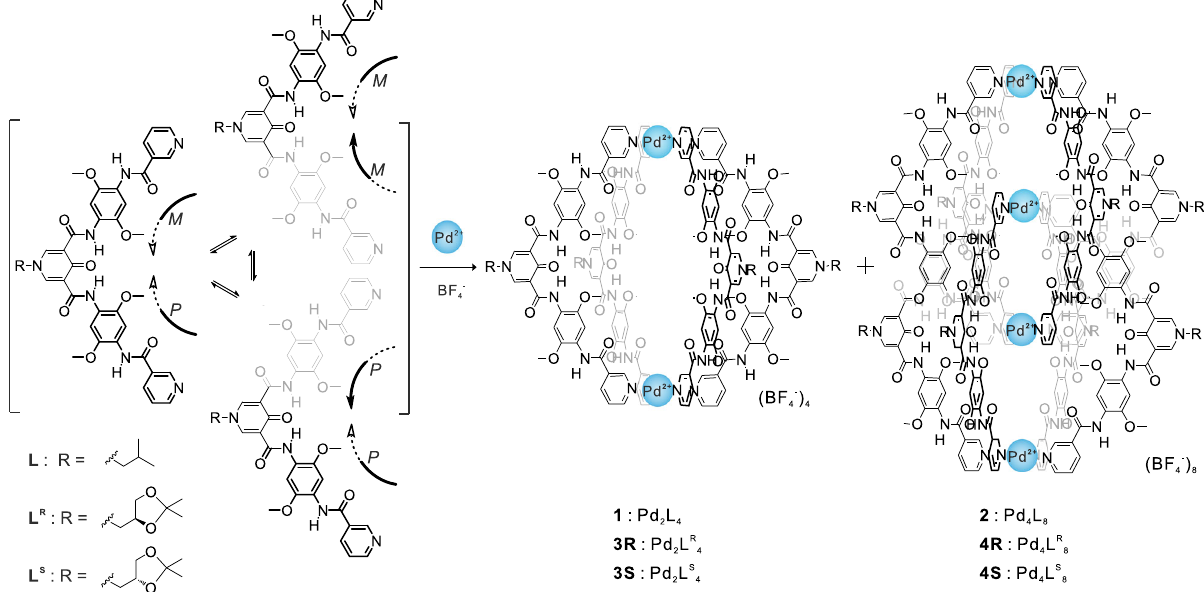
Fig. 1 Synthesis of the monomeric and dimeric helicates. The reaction of the corresponding ligand (2 equiv.) with Pd(BF 4 ) 2 (1 equiv.) led to the formation of the mixtures of the monomeric and dimeric